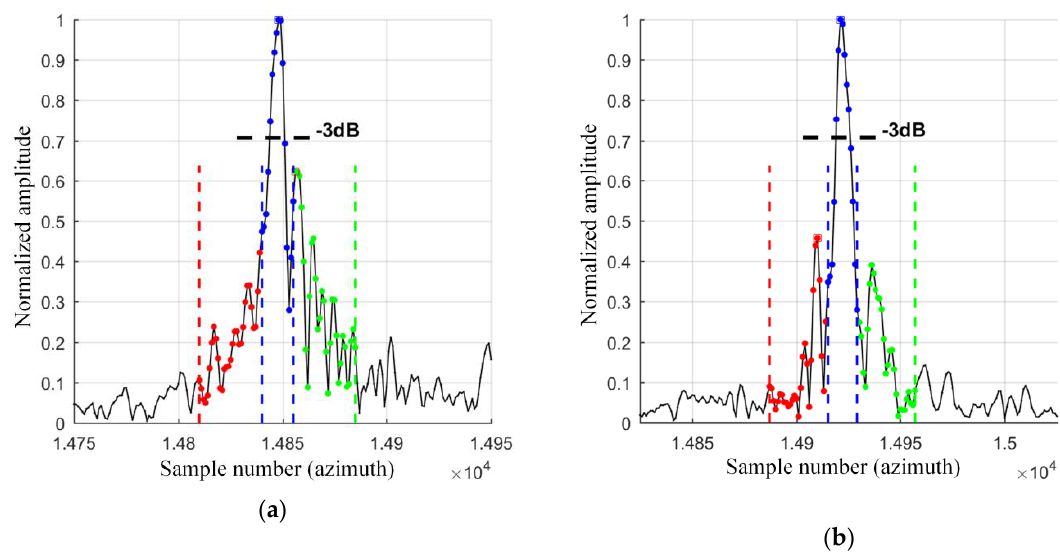
Figure 22. Normalized amplitude of the selected corner reflector image: ( a ) with the INS-based MOCO, ( b ) with the MINS-based MOCO.